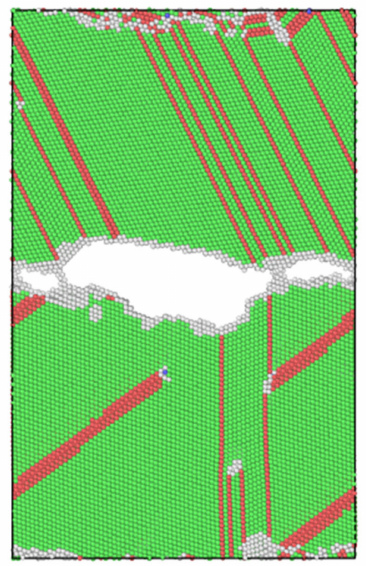
Figure 5. Bicrystal with chromium segregation at 12% strain. Twins are shown in red. Atoms of the disordered structure are shown in